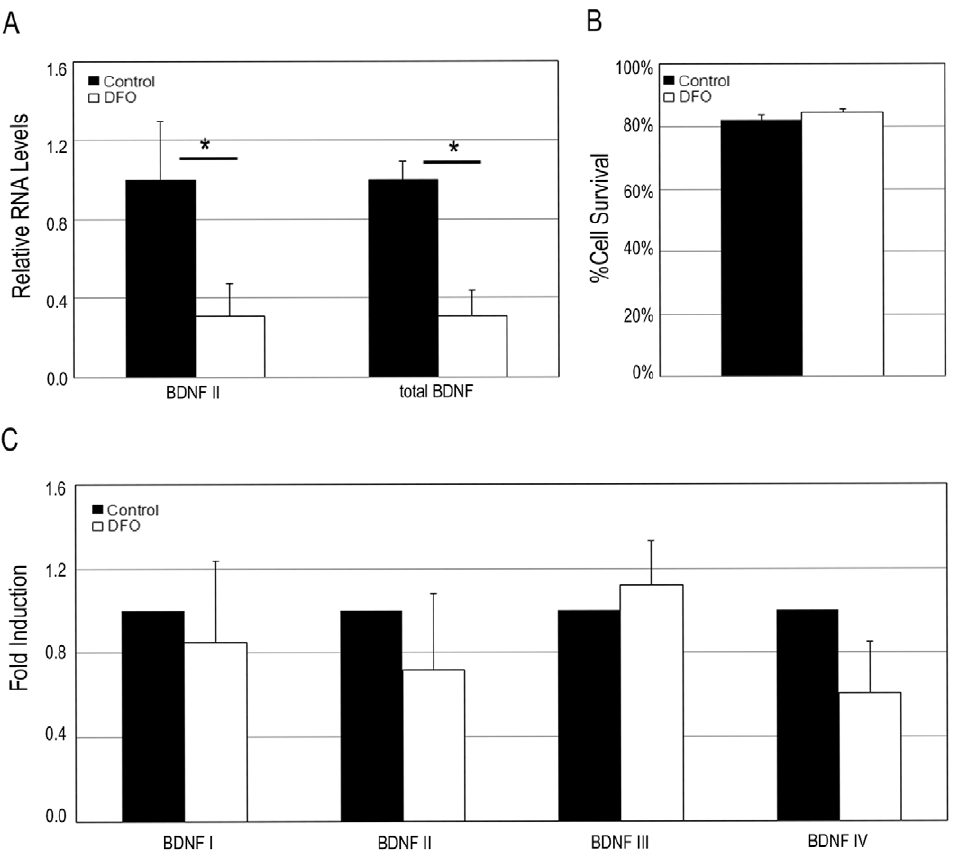
Figure 3. Iron chelation decreases BDNF expression in human neuroblastoma cells. A. SH-SY5Y cells were treated with either vehicle or 100 m M deferoxamine (DFO) for 24 hours. RT-PCR measures of BDNF transcripts show a decrease in total BDNF transcripts (tBDNF, variants 1–14, 16–18 (*p , 0.01, n=4–5). B. Iron chelation did not cause changes in cell survival as assessed by trypan blue exclusion 24 hours post-treatment (n=5). C. SH-SY5Y cells were transfected with luciferase reporters for the promoter regions of BDNF I–IV and were then treated with 100 m M deferoxamine for 24 hours. No significant differences were observed between control and treated cells (n=3–4).